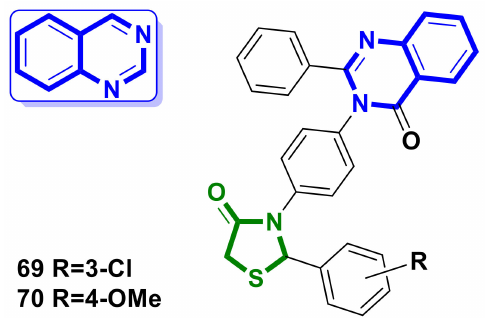
Figure 26. Quinazoline-bearing hybrid molecules with 4-thiazolidinone scaffolds as potential anti- cancer agents.